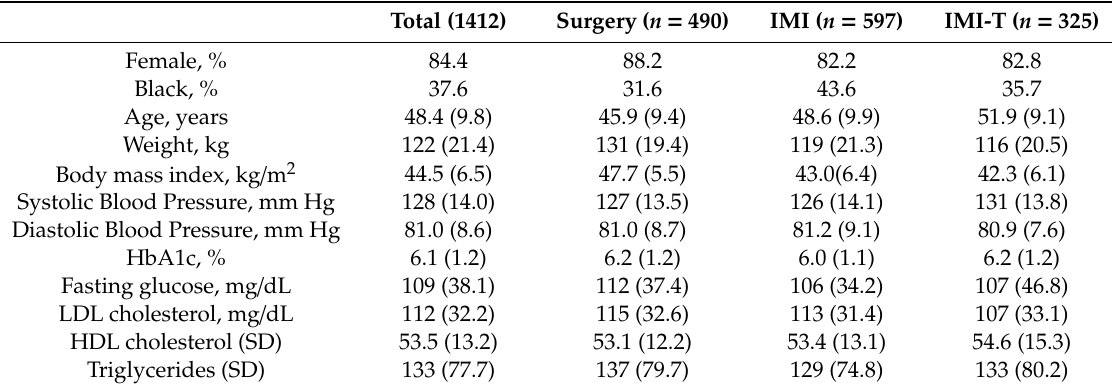
Table 1. Descriptive characteristics of enrolled population.